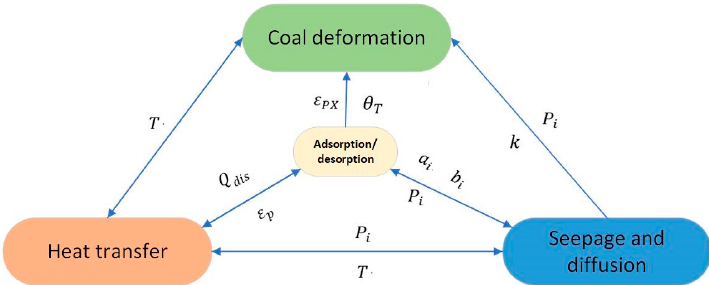
Figure 1. Schematic diagram of the full coupling of THM for CO 2 displacement CBM.